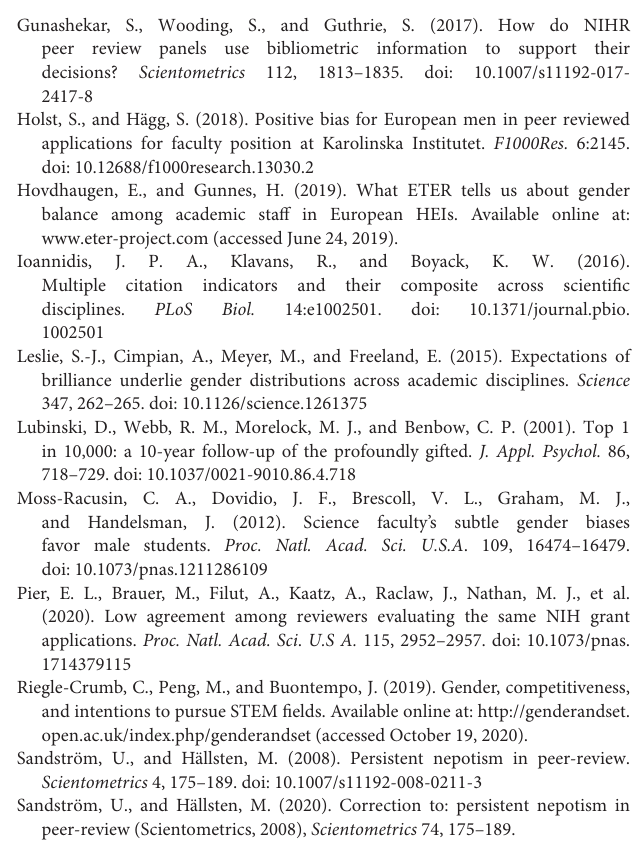
Supplementary Figure 1 | Linear regression associations between composite bibliometric scores and external reviewer scores received on merits, stratified by gender, and divided by each year for applications to Assistant Professor positions (A-D) and for applications to Senior Researcher positions (E-H) . Model outputs are found in Supplementary Table 1. Supplementary Table 1 | Association between composite bibliometric scores and external reviewer scores by year and